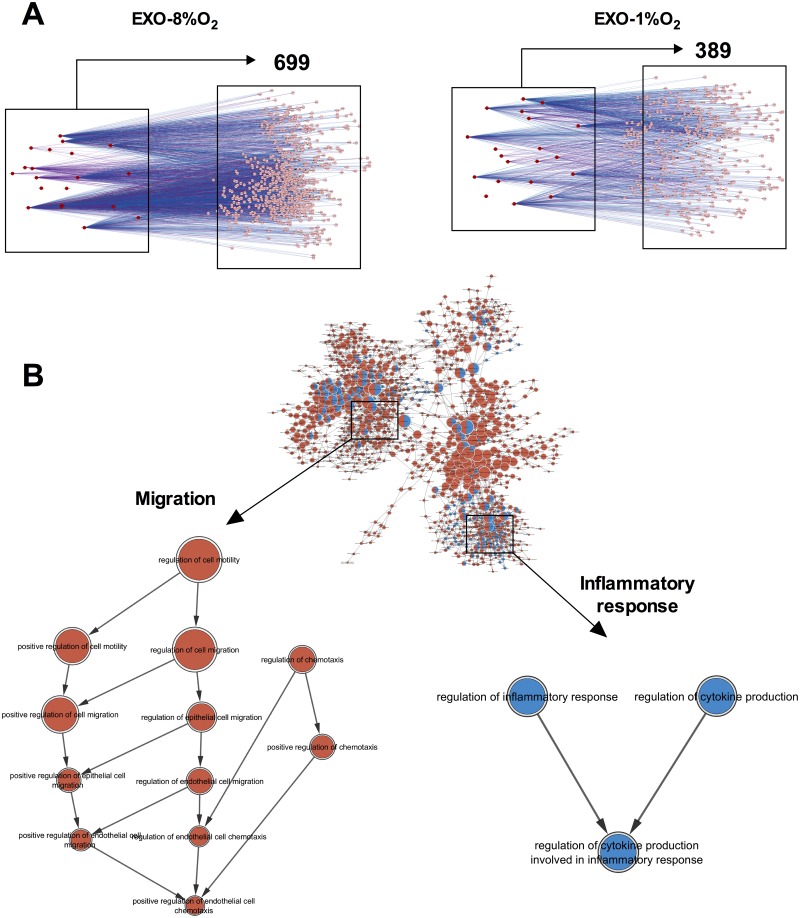
Target gene prediction of miRNAs identified in EVT-derived exosomes.(A) Gene target identification using CyTargetLinker was performed on the top 20 miRNAs in exosomes from EVT cultured at 8% or 1% oxygen. The genes were identified to be regulated by at least two of our candidate miRNAs, and are detected within at least two miRNA-gene target databases. (B) Top: Gene Ontology analysis using BiNGO was performed on all genes and displayed as a network. Bottom: Gene ontology pathway extracted from exosomes obtained from EVT at 8% and 1% oxygen showing the “migration” and “inflanmmatory response” gene ontology term, respectivetly.